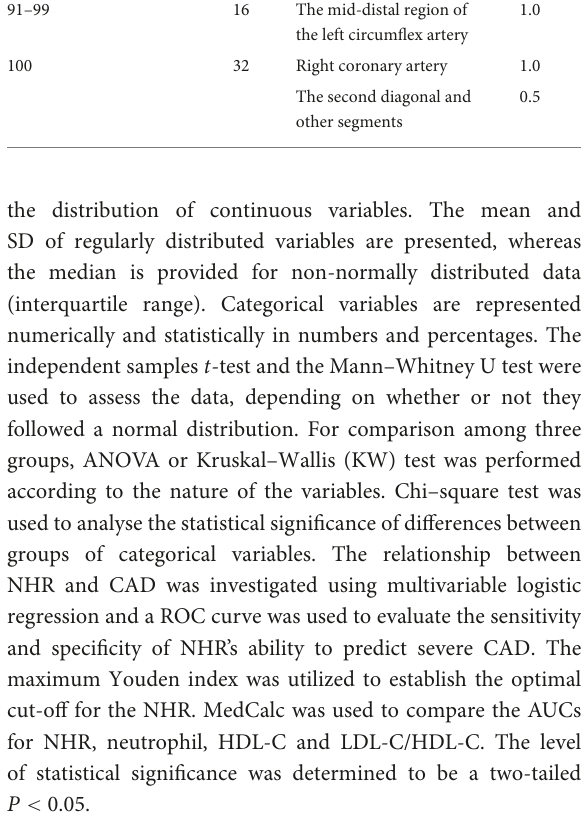
population stratified by tertiles of Gensini score. P for trend was calculated with each tertile of Gensini score taken as a unit. The participants with the highest tertile of Gensini score had higher levels of BMI, WBCs, neutrophils, CRP, HbA1c, Cr, NHR,